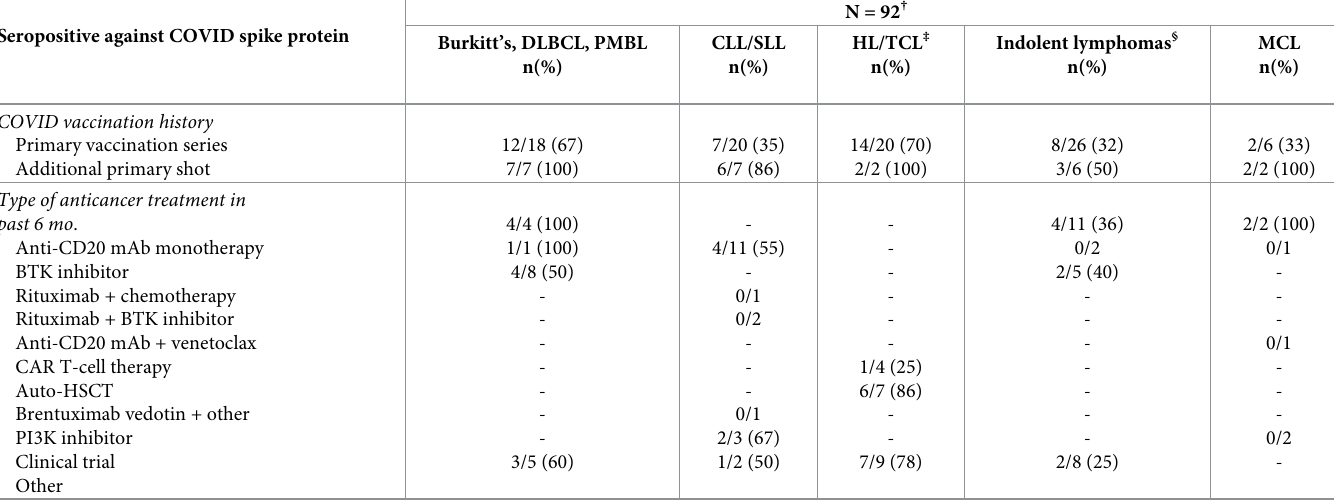
Table 3. Serologic response against COVID spike protein in patients who received anticancer treatment in the previous 6 months. Seropositive against COVID spike